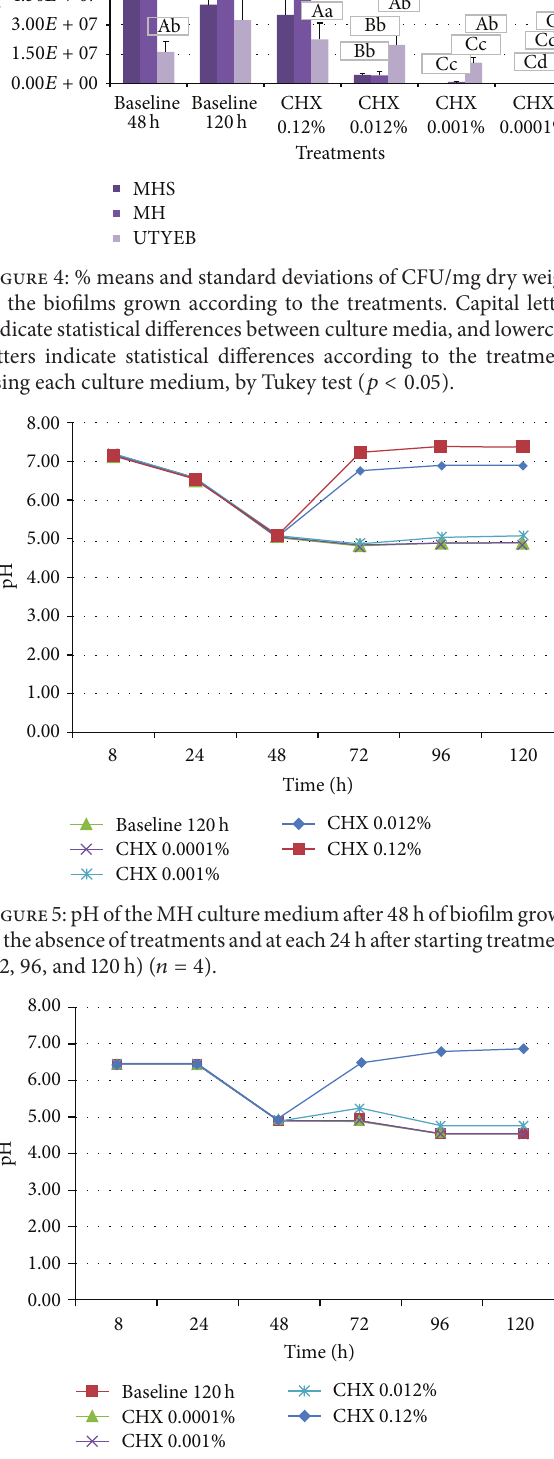
Figure 6: pH of the MHS culture medium after 48 h of biofilm growth in the absence of treatments and at each 24 h after starting treatments (72, 96, and 120h) ( 𝑛 = 4 ).